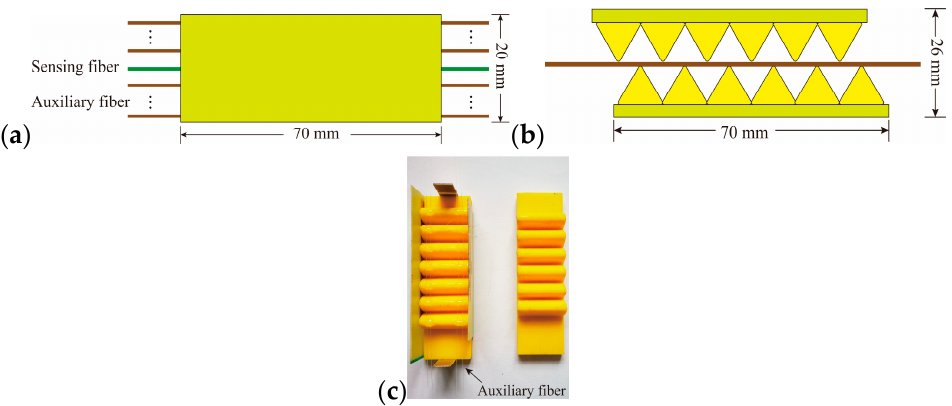
Figure 6. Schematic diagram and picture of the optical pressure sensor; ( a ) top view of the pressure sensor; ( b ) front view of the pressure sensor; ( c ) picture of the pressure sensor.